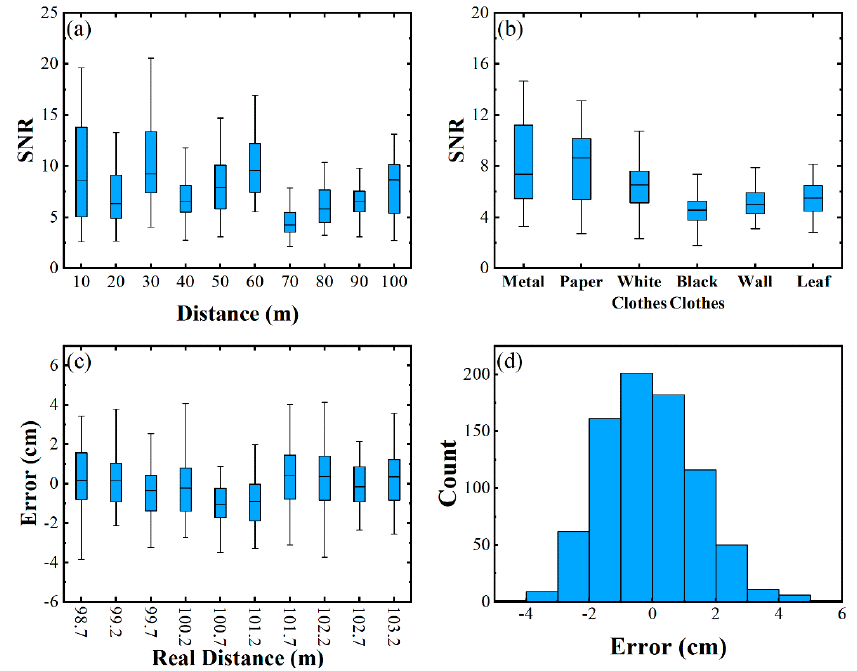
Figure 7. ( a ) SNR of paper at different distances, ( b ) SNR of different targets at 103.2 m, ( c ) uncer - tainty test near 100.0 m, ( d ) error distribution between measured value and actual value.